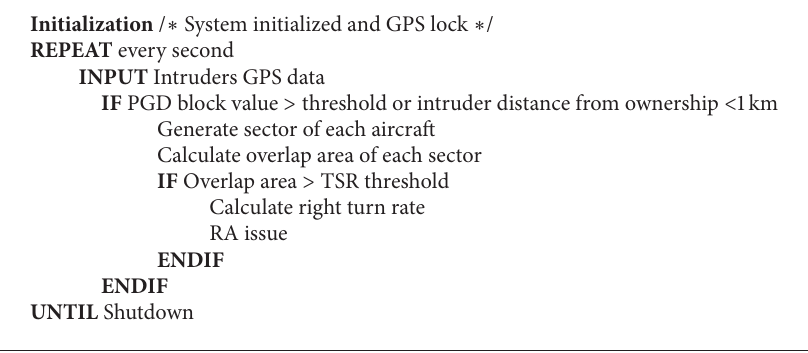
Algorithm 4: TSR CD&R architecture.